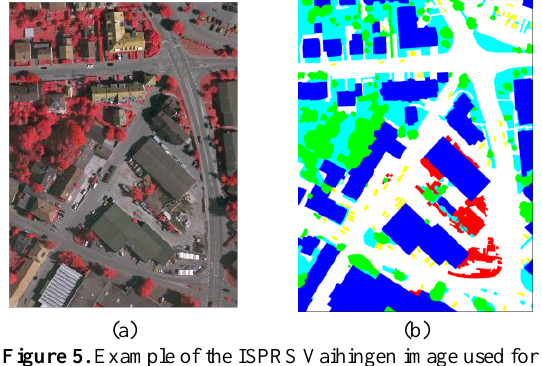
Figure 5. Example of the ISPRS Vaihingen image used for training with corresponding ground-truth.